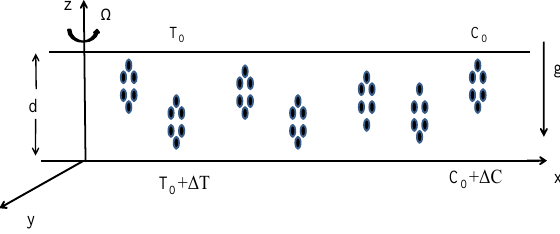
Figure 1. Physical